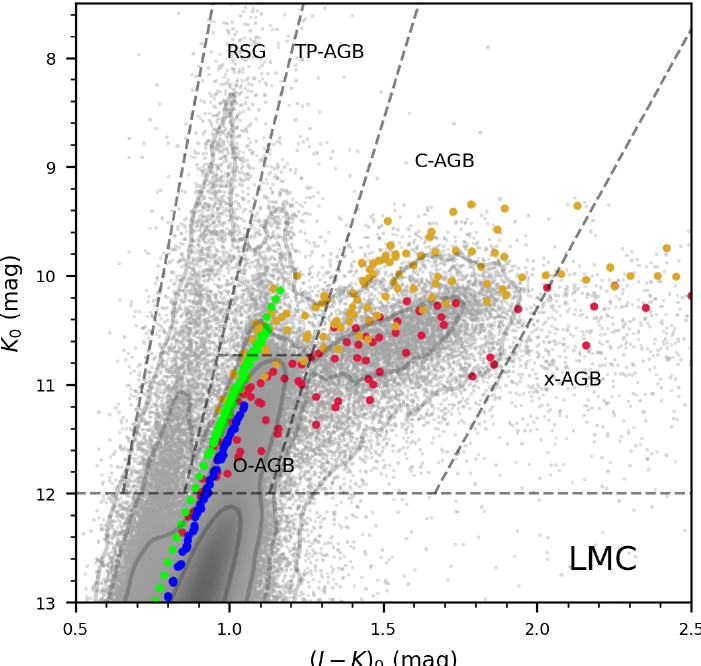
Figure 5. Verification of the classification areas in Figure 1 with Padova stellar evolutionary models. The red and blue dots represent C-AGBs and O-AGBs at an age of 1.00 Gyr, respectively, and the yellow and green dots represent C-AGBs and O-AGBs at an age of 0.63 Gyr, respectively. The background is the sample stars in the LMC from Paper